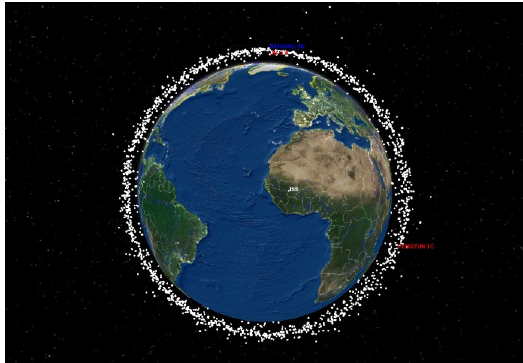
Figure 5d. Modeling and Visualization of space scrap running within orbit Figure 5. Modeling and Visualization of space moving objects